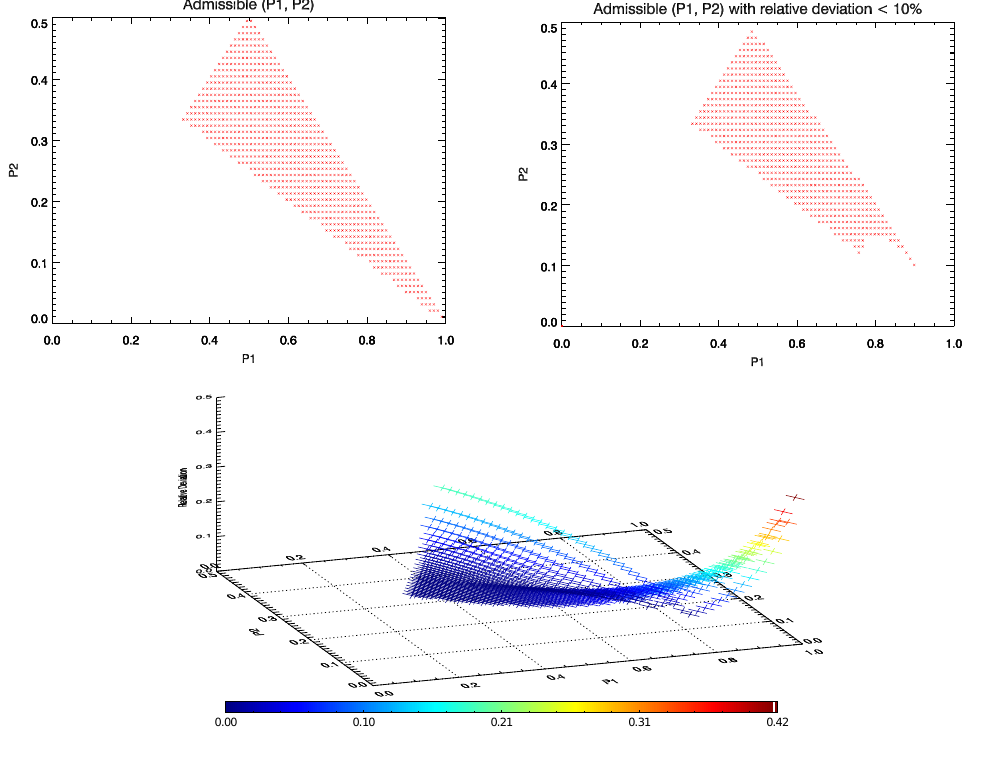
( q ) ( q ) ) pairs. ( Top Right ) plot of , p 2 1